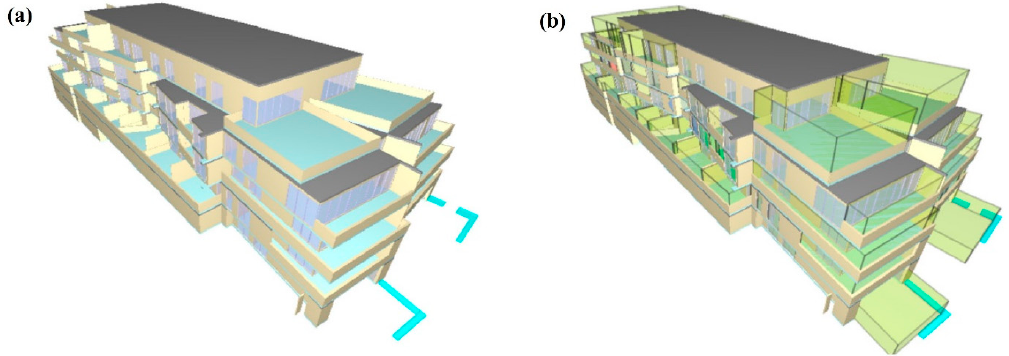
Figure 8. The case study multi-owned building: ( a ) Physical representation, ( b ) Ownership spaces integrated with the physical representation.